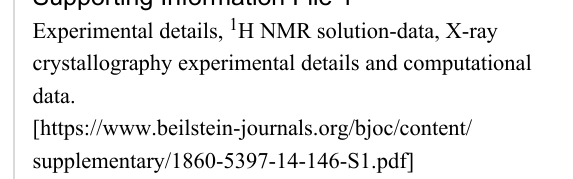
Table 3: Summary of endo / exo host–guest complexations studied in solution by 1 H NMR in comparison to the solid state by single crystal X-ray